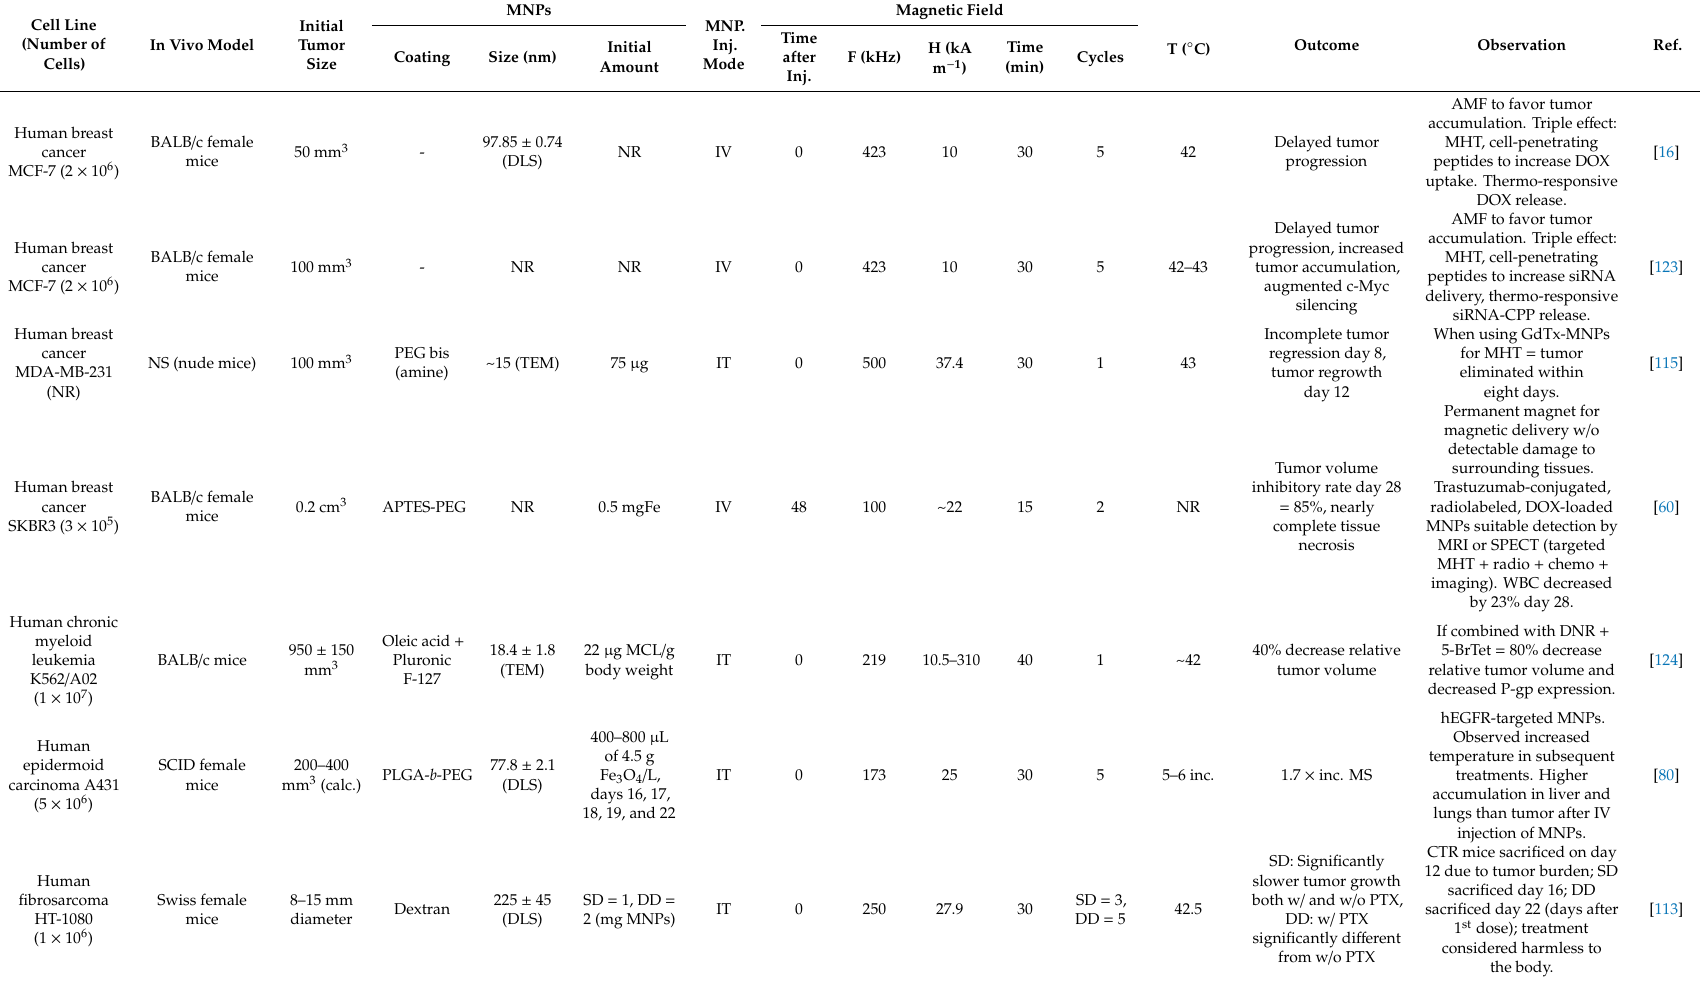
Table A3. In vivo studies using passive or active targeted anti-cancer